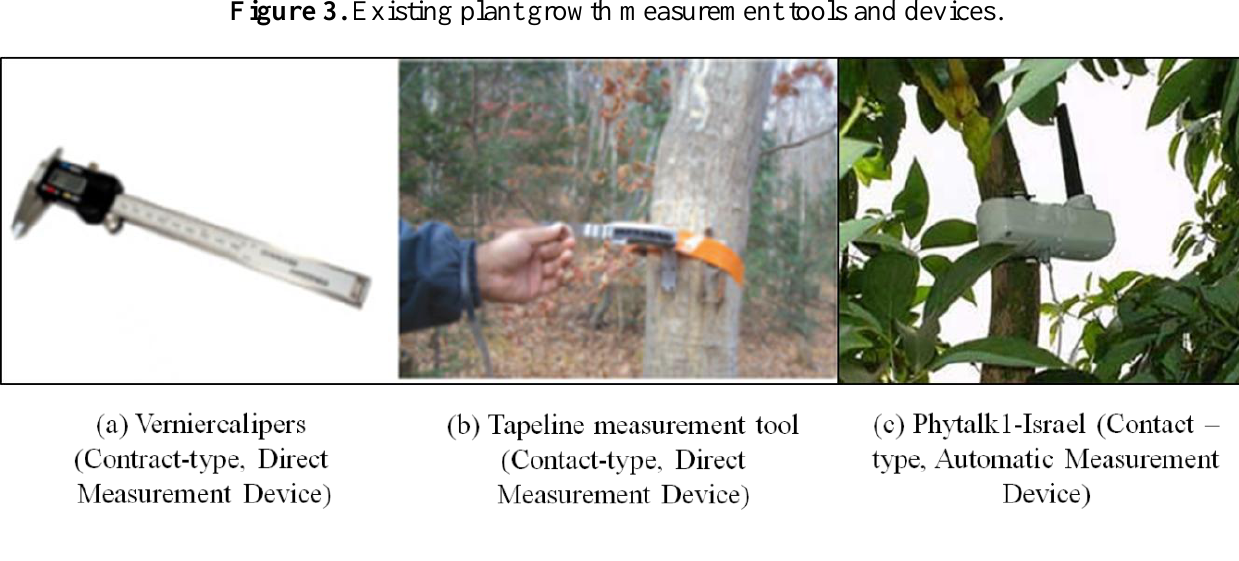
Figure 3. Existing plant growth measurement tools and